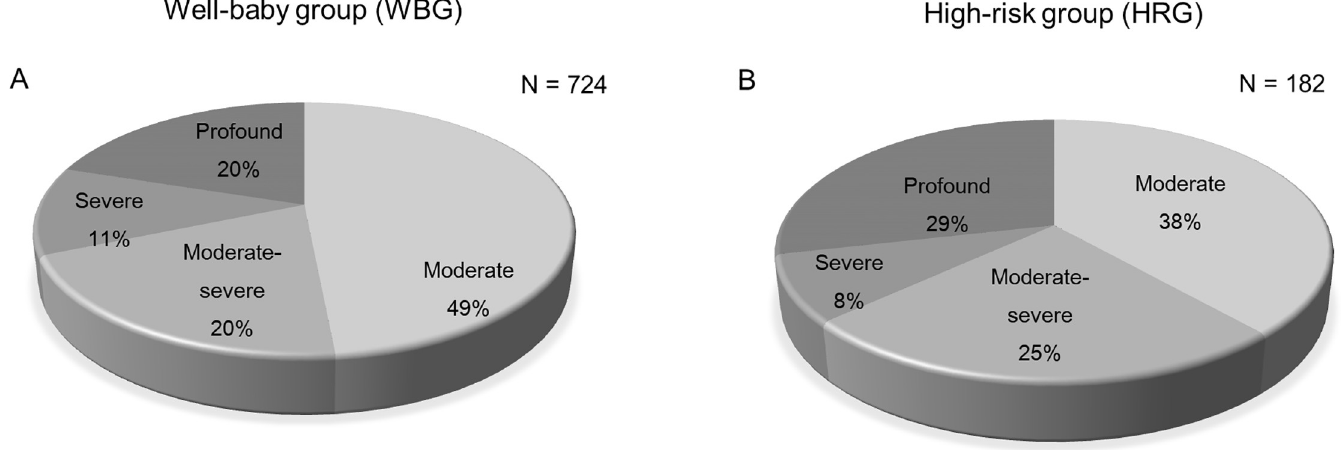
Fig 3. The distribution of hearing loss (HL) according to the degree of HL in WBG and HRG (N = ear). A. The proportion of ears with hearing impairment in WBG. Total of 724 ears had HL; 351 (49%) ears had moderate HL, 146 (20%) ears had moderate-severe HL, 82 (11%) ears had severe HL and 145 (20%) ears had profound HL. B. The proportion of ears with hearing impairment in HRG. Total of 182 ears had hearing impairment; 70(38%) ears had moderate HL, 45(25%) ears had moderate- severe HL, 15(8%) ears had severe HL and 52 (29%) ears had profound HL. The degree of HL was not significantly different between WBG and HRG ( p = 0.6025).